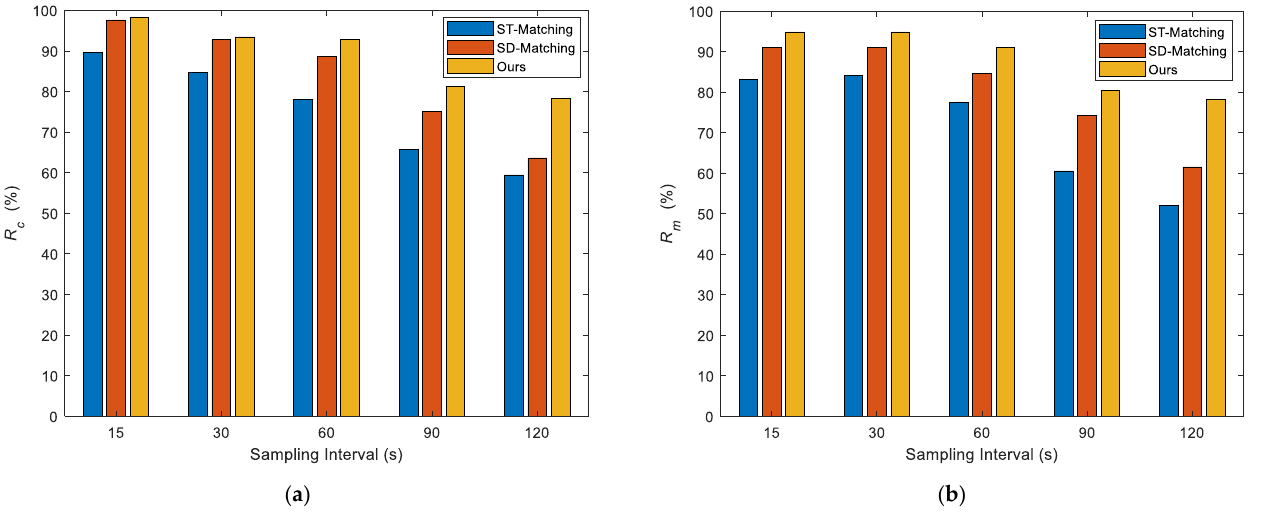
Figure 12. Comparison of the accuracy of the algorithms under different sampling frequencies. ( a ) Comparison of the R c indicators. ( b ) Comparison of the R m